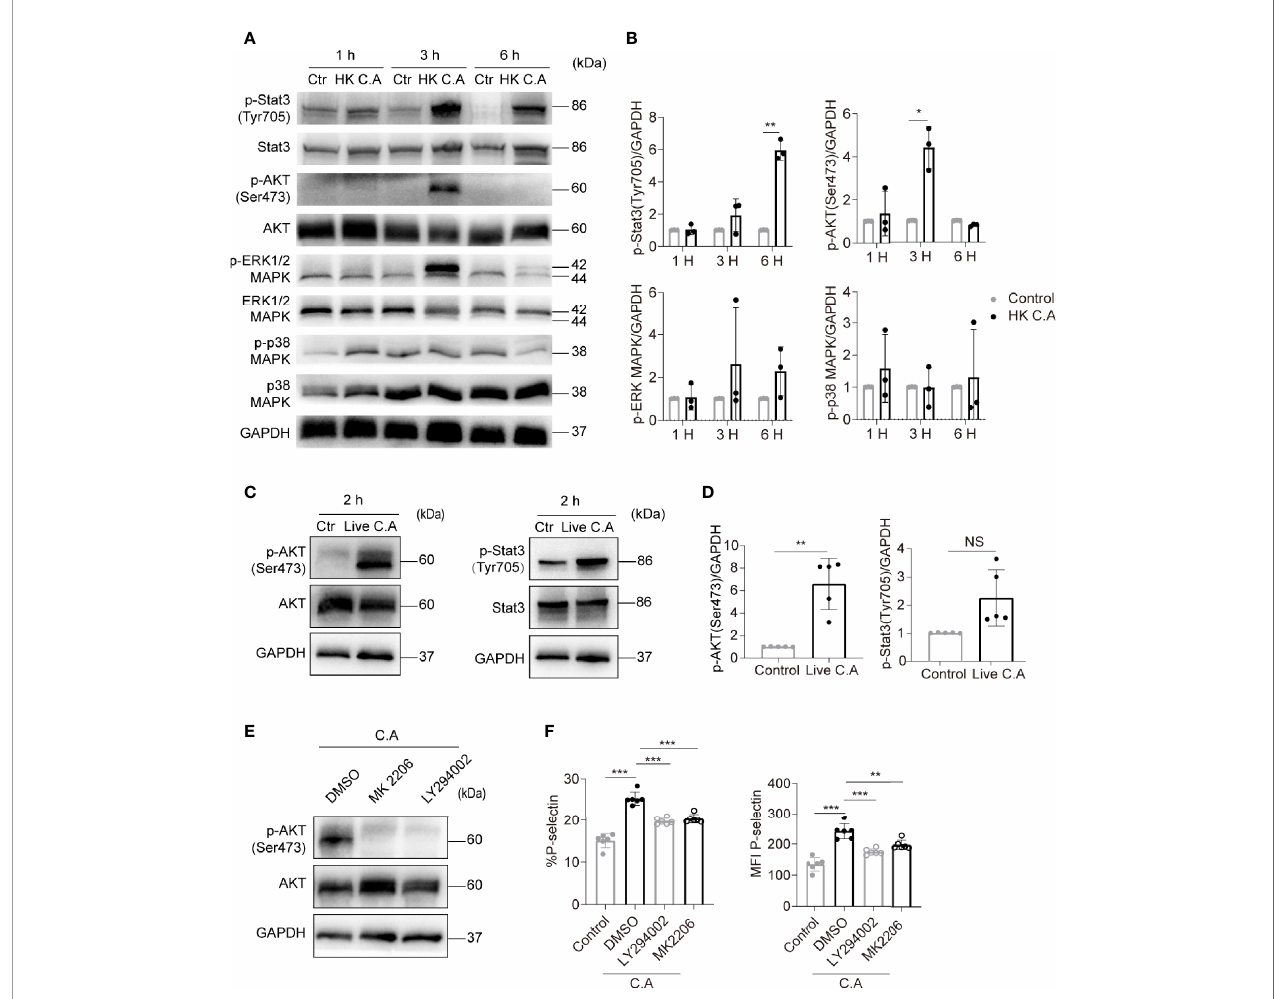
FIGURE 2 | C. albicans induces platelet activation through the PI3K-AKT signaling pathway. (A – D) Western blot analysis of protein levels in human platelets treated with HK C. albicans (A, B) for 1 h, 3 h, or 6 h or live C. albicans (C, D) for 2 h at an MOI of 0.01. PRP incubated with equal volume of PBS was used as control. The data are representative of three or more independent experiments. (E, F) Human platelets were pretreated with the PI3K inhibitor LY294002 (90 m M), Akt inhibitor MK2206 (30 m M), or vehicle control at 37°C for 2 h and then incubated with live C. albicans at 37°C for 2h. Western blot analysis of Akt phosphorylation with anti- pAkt Ser-473 antibodies is shown (E) . The expression of P-selectin was detected by fl ow cytometry. The percentages (F left column) and MFI ( F right column) of P- selectin-positive cells were calculated. Data are expressed as the mean ± SD; * P < 0.05, ** P < 0.01, *** P < 0.001, compared with the vehicle control via Student ’ s t test. C.A, C. albicans ; Ctr, control; HK, heat-killed; NS, not signi fi